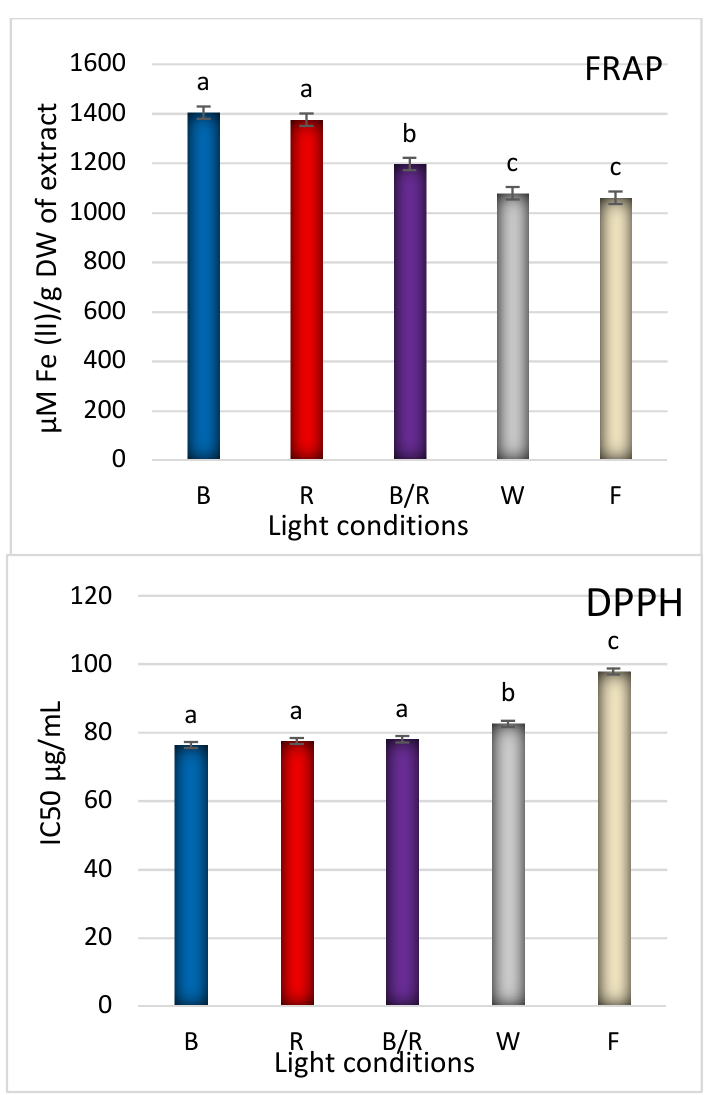
Figure 8. The effect of light conditions: (B) blue, (R) red, (B/R) blue/red, (W) white, (F) fluorescent on the antioxidant capacity (FRAP—ferric reducing antioxidant power, DPPH—1,1-diphenyl-2-picrylhydrazyl) of hydromethanolic extract from shoots of D. forrestii . The values represented means ± SE of three independent experimental replicates. The means marked with various letters for the same parameter were different at p < 0.05 according to one way ANOVA test followed by the post-hoc Tukey’s test. Table 2. Correlation coefficient between antioxidant activity and phenolic content in D. forrestii shoot culture under various light